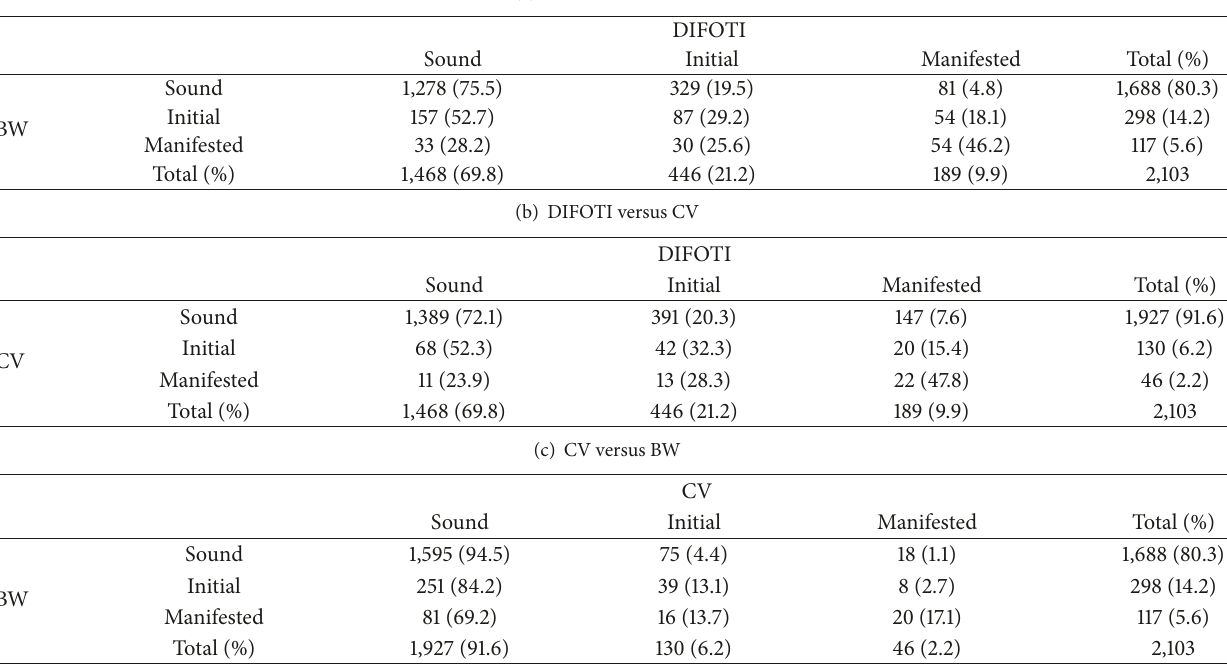
Table 2: Comparison of the findings of the fiber-optic transillumination (DIFOTI) method with bitewing (BW) radiographs and the clinical visual method (CV). Numbers and proportions (%) of tooth surfaces with different stages of caries lesions.